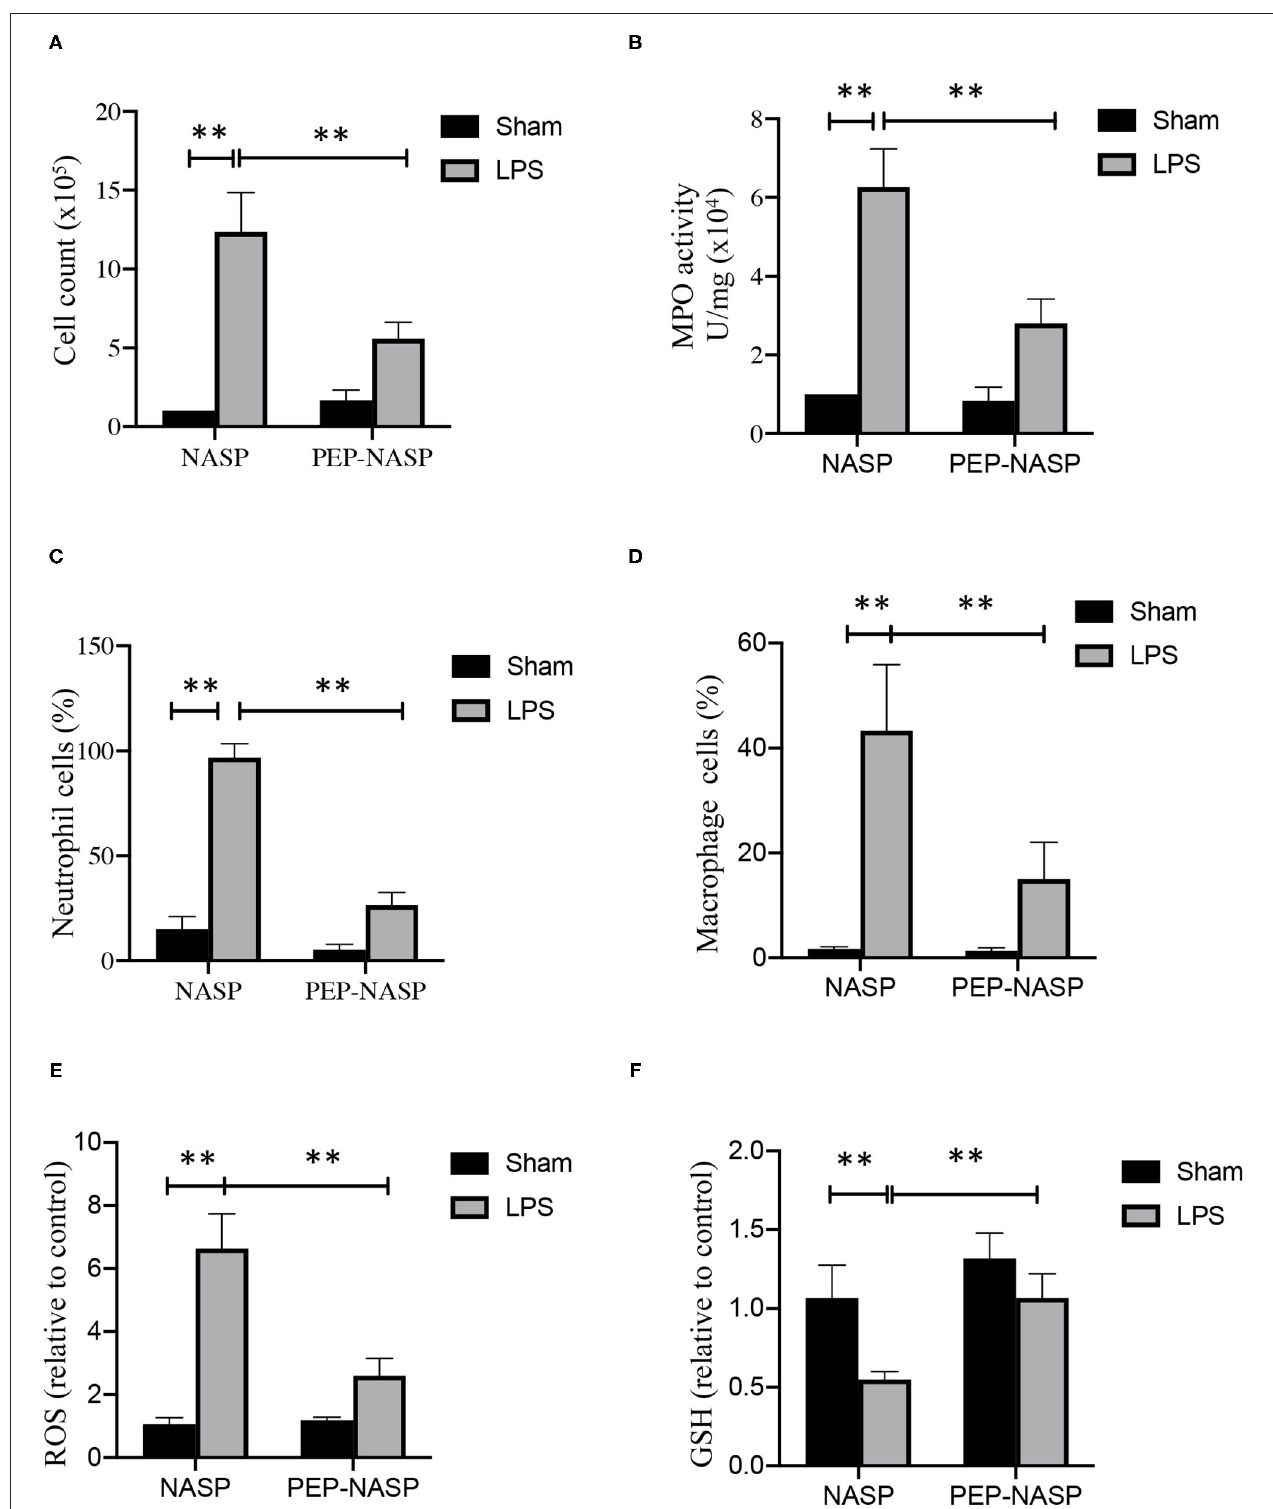
FIGURE 8 | The PEP-NASP inhibited the infiltration of inflammatory cells in LPS-induced acute lung injury. (A) Total infiltrated cells in bronchoalveolar lavage fluid (BALF) were counted using a counting chamber. (B) Effect of the PEP-NASP on myeloperoxidase (MPO) activity in lung tissue homogenates. (C,D) Statistical analysis of percentages of neutrophils and macrophages in BALF by hemocytometer and Wright-Giemsa staining. (E) Production of ROS and (F) GSH level were measured in BALF. Values represent the mean ± standard error of the mean (SEM), n = 10, ** p < 0.01 (by a one-way ANOVA).